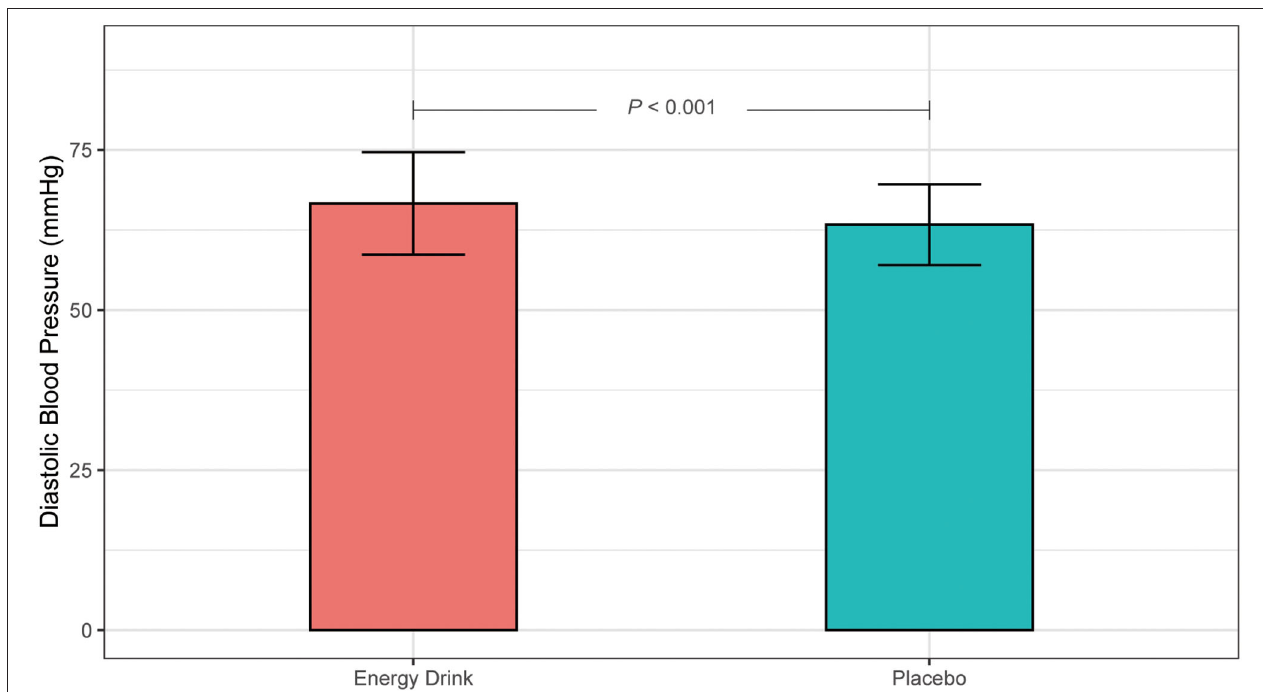
FIGURE 3 | Main effect of Energy Drink and placebo consumption on diastolic blood pressure